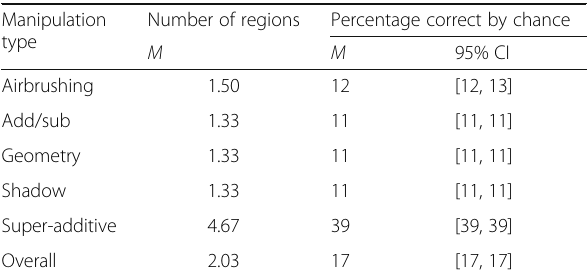
Table 3 Mean number of regions (out of a possible 12) containing manipulation and results of Monte Carlo simulation to determine chance performance in location task by manipulation type and overall